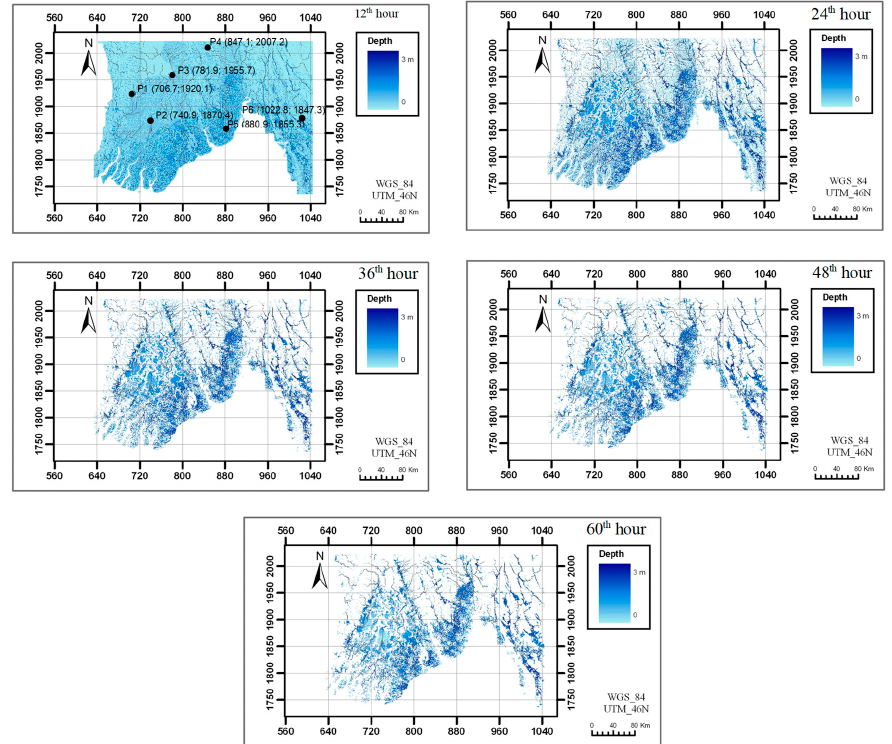
ff erent simulation times. Water 2020 , 12 , x FOR PEER REVIEW